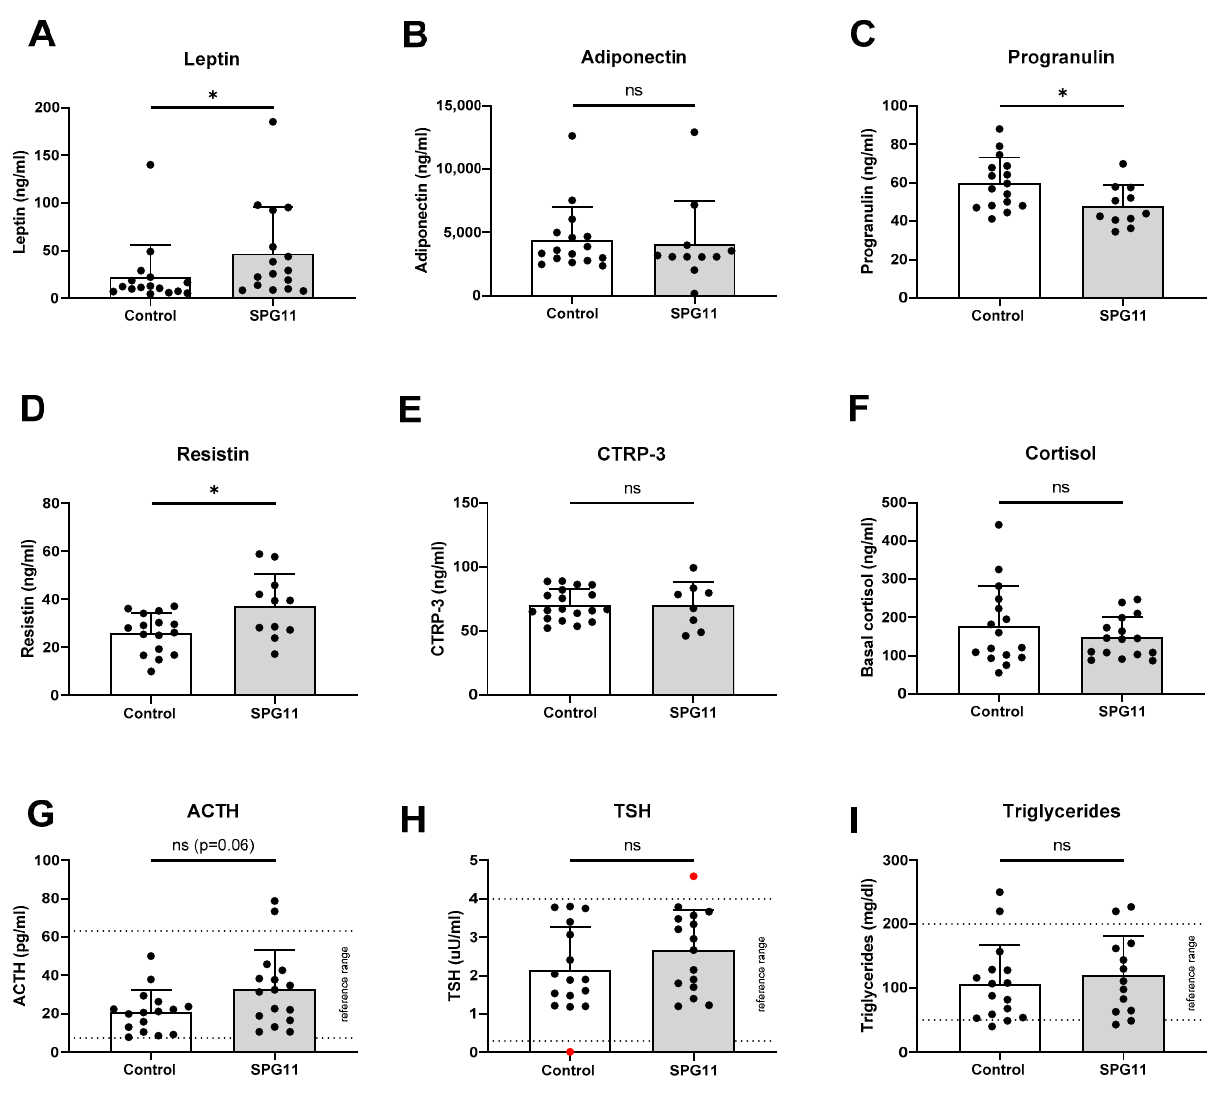
Figure 3. Altered levels of leptin, progranulin, and resistin in SPG11. ( A – E ) Levels of adipocytokines in SPG11 patients compared to controls, including ( A ) leptin, ( B ) adiponectin, ( C ) progranulin, ( D ) resistin, and ( E ) CTRP-3. ( F – H ) Basal levels of cortisol ( F ), adrenocorticotropic hormone (ACTH, G ), and thyroid-stimulating hormone (TSH, H ) were within normal range in most patients and there was no significant difference to controls. Red data points in H indicate subjects with known thyroid function disorder. ( I ) Basal triglyceride levels were within normal limits in most patients and controls. Dotted lines indicate reference ranges. Bars indicate means ± SD. ns: not significant, * p < 0.05.